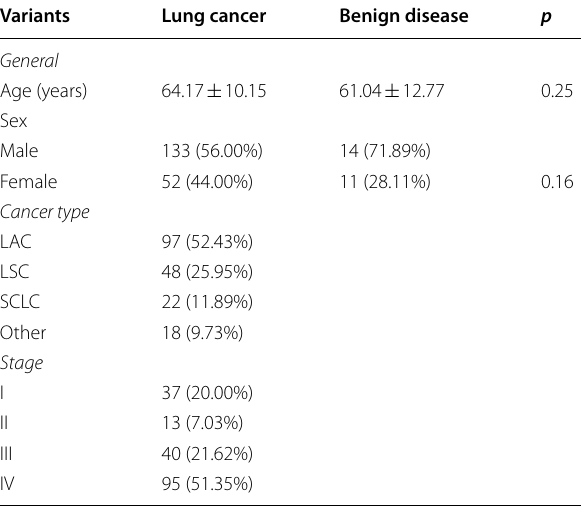
Table 1 Clinical characteristics of 210